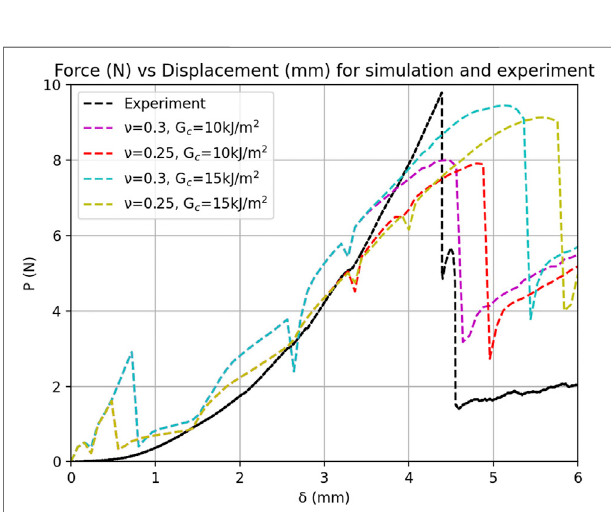
FIGURE11| Experimentalvs.CalibratedSimulatedresultsforDryEDLC for different Poisson ’ s Ratio and Fracture Energy values, with incorporated fracture effect.